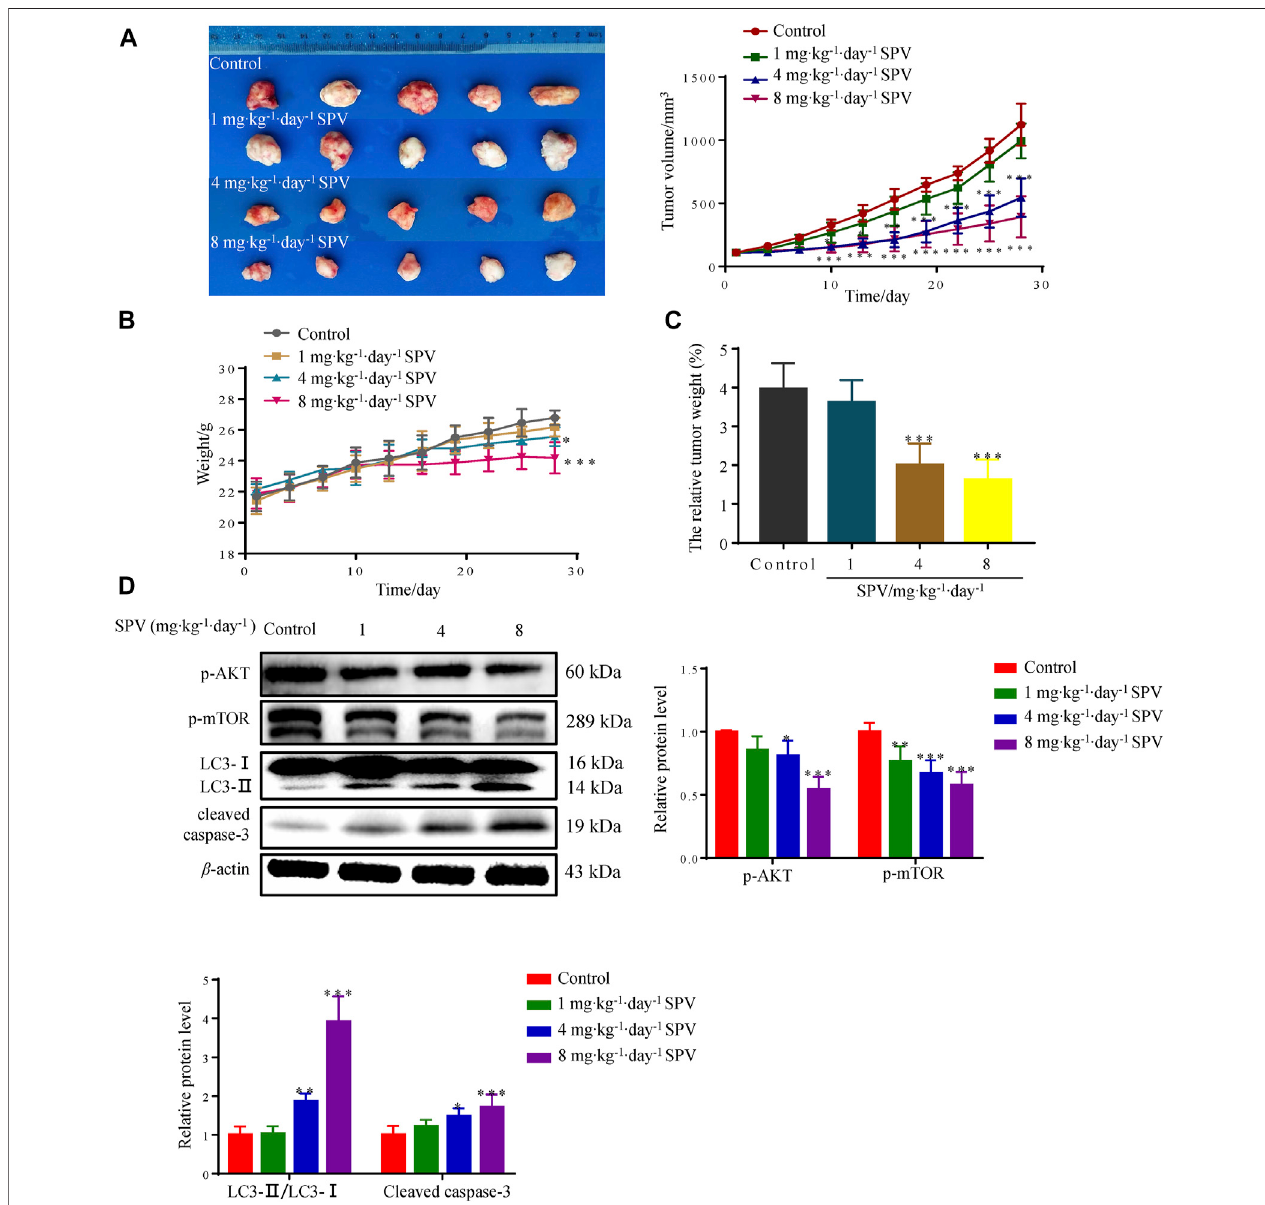
Figure8| SempervirinecaninhibitthegrowthofU251inthenudemicexenograftedmodel. (A) Theimageofsempervirineinhibitingthegrowthofglioma(U251)cell transplant tumor with sempervirine concentration of 0, 1, 4 and 8 mg · kg − 1 · day − 1 after 28 days. And the tumor volume changes in four groups with sempervirine concentration of 0, 1, 4 and 8 mg · kg − 1 · day − 1 after 28 days. (B) The change of nude mice weight between four groups with sempervirine concentration of 0, 1, 4 and 8 mg · kg − 1 · day − 1 after28days. (C) Therelativetumorweightdifferenceinfourgroupswithsempervirineconcentrationof0,1,4and8 mg · kg − 1 · day − 1 after28days. (D) The protein level of p-AKT, p-mTOR, LC3 and cleaved caspase-3 in the tumor were determined by Western blotting. Data are presented as the Mean ± SD ( n (cid:2) 5). * p < 0.05, ** p < 0.01 and *** p < 0.001 compared with the control group.